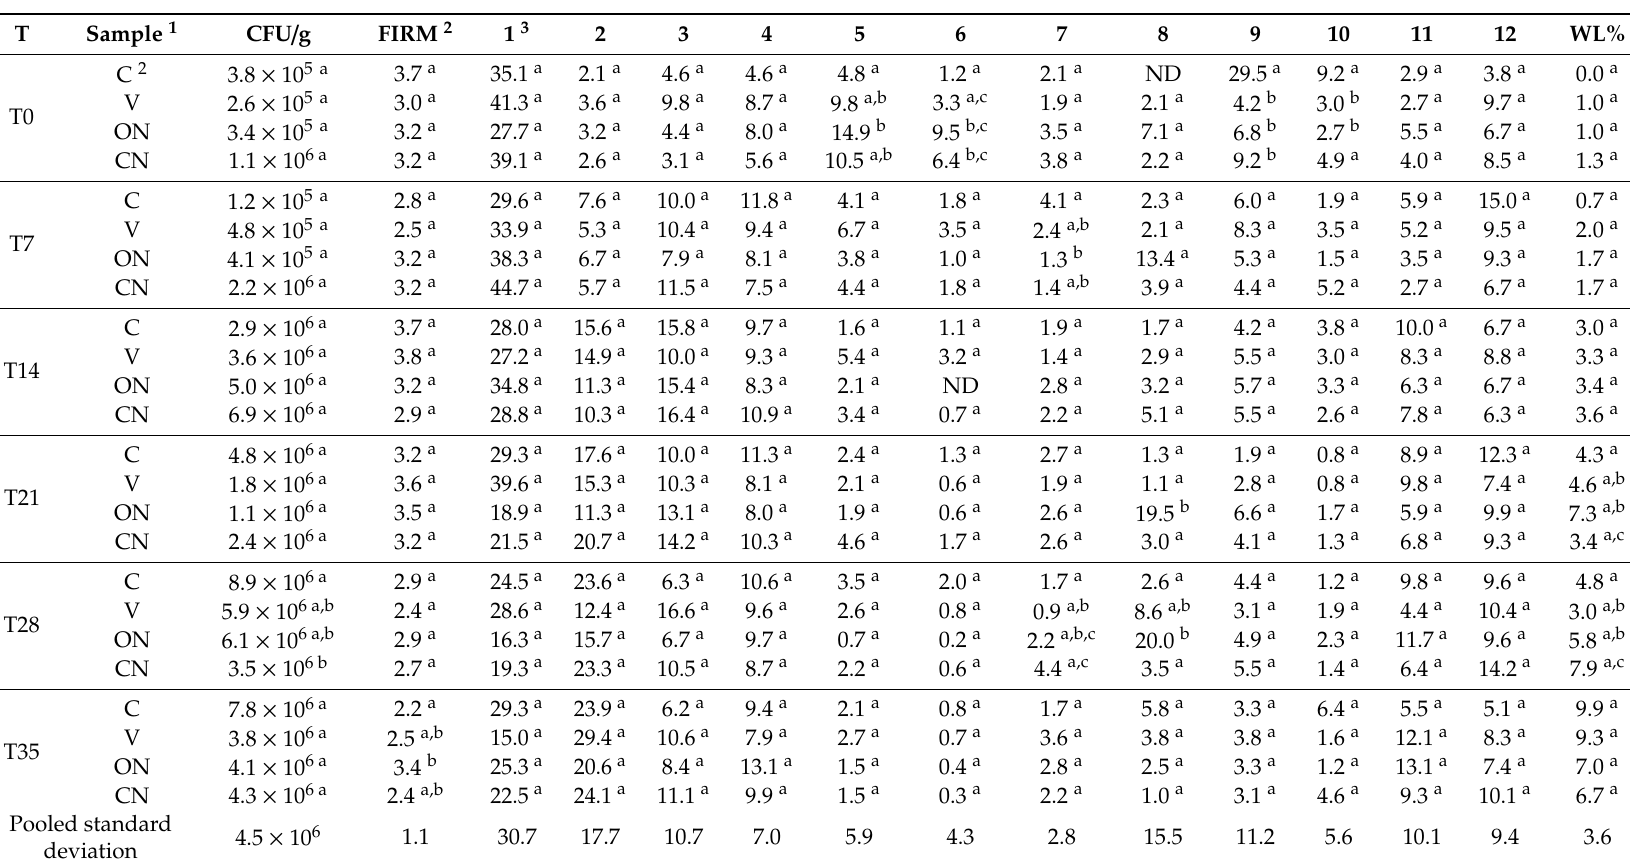
Table 1. Characterization of refrigerated black tru ffl es. CFU (colony-forming units related to the sum of yeasts, fungi, and bacteria), FIRM (Instrumental Penetrometric Determination), volatile compounds (from 1 to 12 ), WL (weight loss) of fresh T. melanosporum initially (T0) and at 7, 14, 21, 28, and 35 days of storage time (T) at 4 ◦ C in di ff erent atmosphere